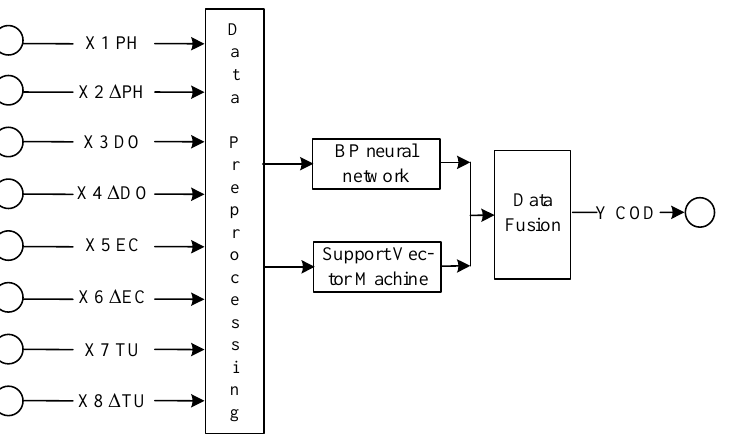
Figure 9. Water quality parameter model based on combination prediction (CWQM).